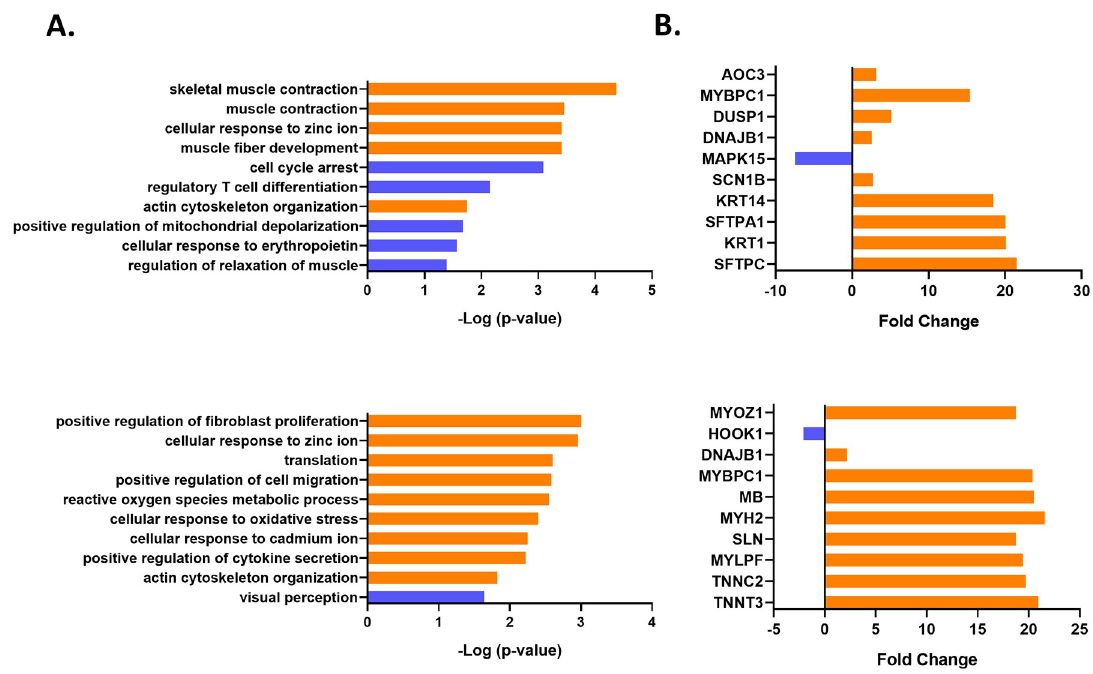
Fig 7. Differential gene expression and pathway analysis after homologous HEV gt1 inoculation. (A). Top 10 functional classification categories, and (B), Top 10 significantly regulated genes ranked by the p-value and fold change. Overrepresented GO terms (in ontologies molecular function, biological process and cellular component) were identified with enrichment scores > 1.3 with a p- value cutoff of >